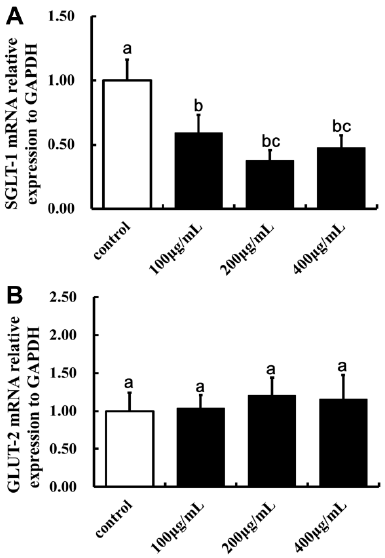
Figure 9. The effect of LBP on the mRNA expression of SGLT-1 and GLUT-2 in Caco2 cells. ( A ) The effect of LBP on the mRNA expression of SGLT-1 in Caco2 cells (one-way ANOVA); ( B ) The effect of LBP on the mRNA expression of GLUT-2 in Caco2 cells (one-way ANOVA). The data are presented as the mean ± SD ( n = 3). The bars without the same letter differed significantly ( p < 0.05).